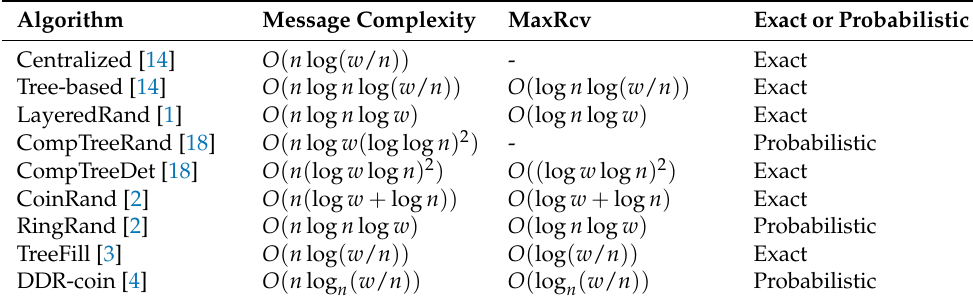
Table 1. Comparison of major performance metrics for DTC algorithms.